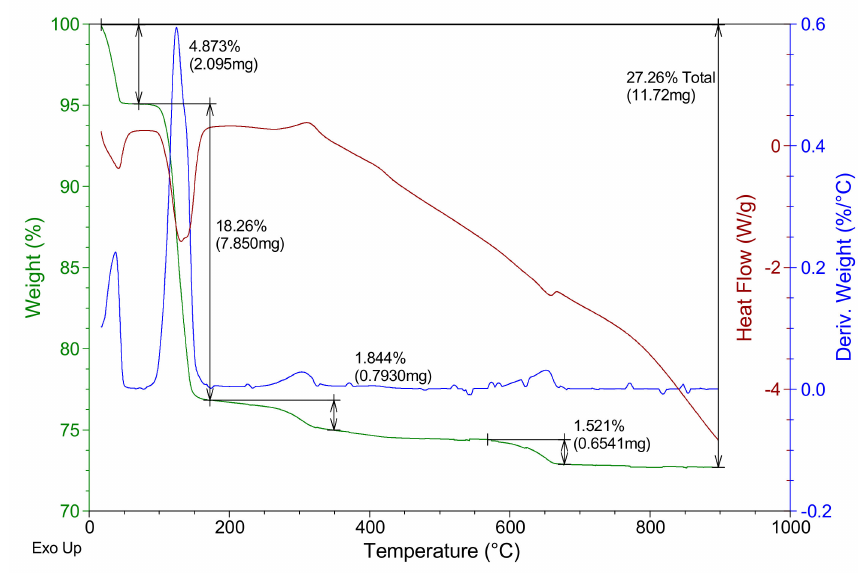
Figure 5. Thermogravimetric analysis of D1 type sample.